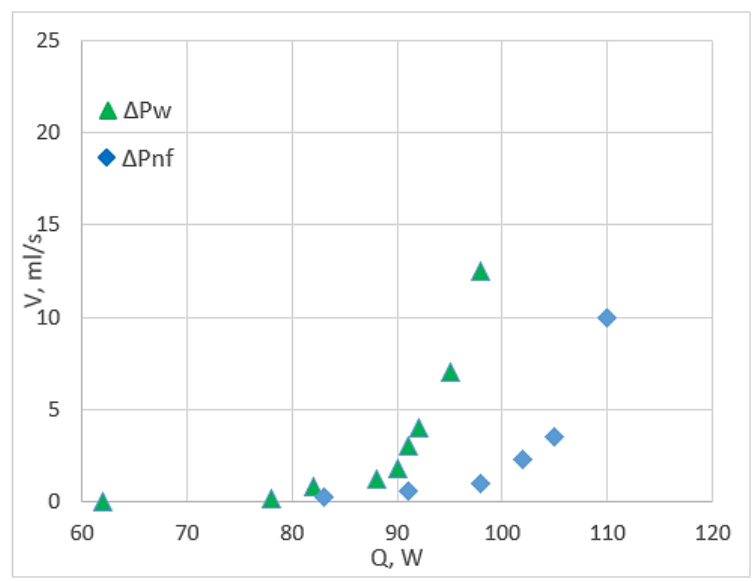
Figure 9. Pressure drop for CuO/water nanofluid and water under different volumes and heat flow rates rates. [70]